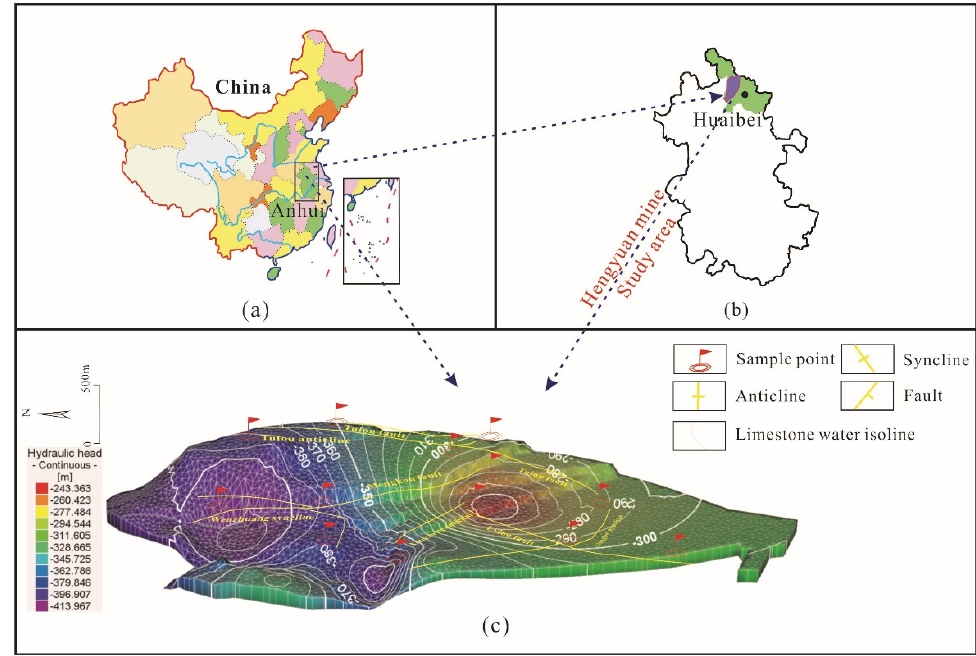
Figure 2. Geographical location of the Hengyuan Coal Mine. ( a ) Anhui Province in China, ( b ) the terrain of Anhui Province and the study area in Anhui Province, ( c ) geological map of the study area and location of sampling points.